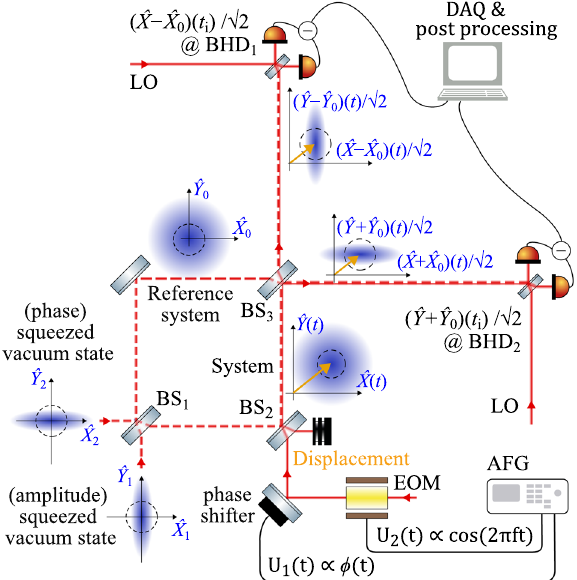
Fig. 2 Schematics of the experiment. Shown are optical paths of laser beams at wavelength 1550 nm. The phase space pictures show the quantum uncertainty of the laser beams' modulations at f = 5 MHz at several instances in the Wigner representation. From bottom left to top right: balanced beam splitter BS 1 converted two squeezed vacuum states into a bipartite EPR entangled state. One part served as a quantum entangled reference (subscript 0). The other part was displaced by ðh ^ X i ; h ^ Y iÞð t Þ (illustrated by the arrow) by overlapping modulated light transmitted through BS 2 . The two projections of the arrow were simultaneous monitored with respect to the entangled reference system by superposition at BS 3 and by detecting the outputs with balanced homodyne detectors. BHD 1 ffiffiffi p 2 provided eigenvalues of ð ^ X (cid:4) ^ X 0 Þð t i Þ = , while BHD 2 provided ffiffiffi p 2 eigenvalues of ð ^ Y þ ^ Y 0 Þð t i Þ = , with h ^ X 0 i ¼ h ^ Y 0 i ¼ 0 . EOM electro-optical modulator, AFG arbitrary function generator, DAQ data acquisition, LO local measurement (port B in Fig. 1, left), if not an entangled reference system is superimposed via this port, as shown in in Figs. 1b and 2. In the absence of quantum correlations, simultaneous measurements at times t i need to cope with at least doubled minimal quantum uncertainty, which increases